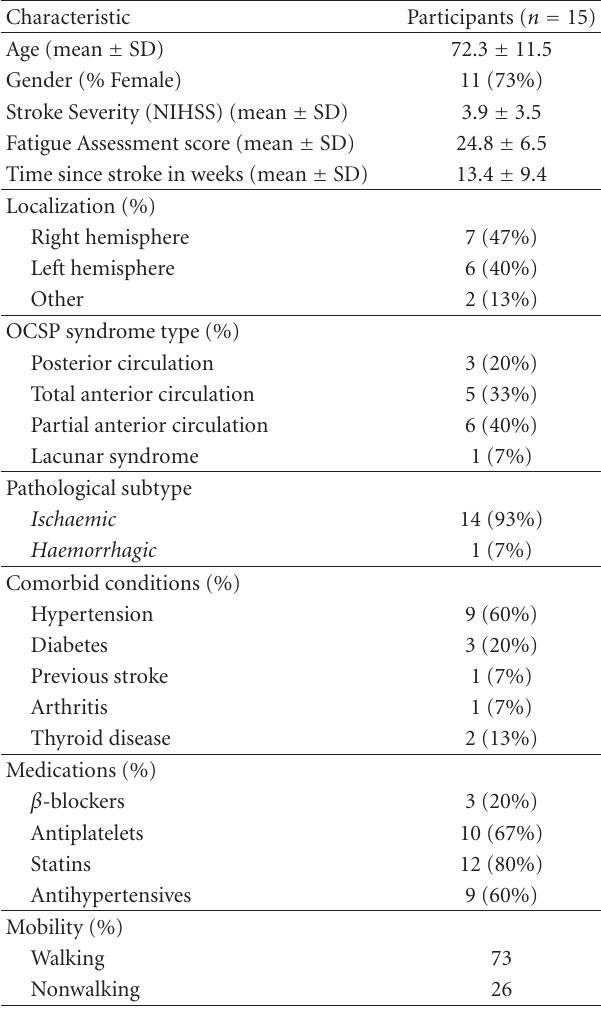
Table 1: Characteristics of